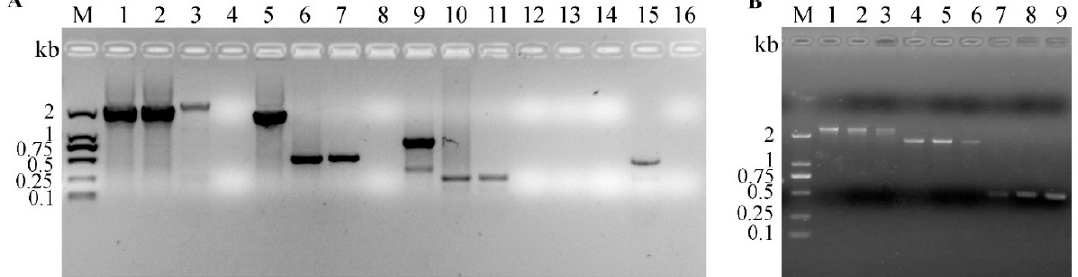
Figure 1. Identification of BoHV-1 gG-/tk-/gE- triple mutant by PCR. ( A ) A fragment of 2183 bp of the intact gE gene fragment in wt BoHV-1 (Lane 1) and BoHV-1 gG-/tk- (Lane 2), and a fragment of 2395 bp including the whole egfp gene and parts of the flanking upstream and downstream sequences (Lane 3) are shown. In addition, the gG gene fragment in wt BoHV-1 (Lane 5), BoHV-1 gG-/tk- (Lane 6), and BoHV-1 gG-/tk-/gE- (Lane 7), and the tk gene fragment in wt BoHV-1 (Lane 9), BoHV-1 gG-/tk- (Lane 10), and BoHV-1 gG-/tk-/gE- (Lane 11) are shown. A fragment of 481 bp including parts of upstream homologous arm gene and egfp gene was detected in BoHV-1 gG-/tk-/gE- (Lane 15), but not in wt BoHV-1 (Lane 13), BoHV-1 gG-/tk- (Lane 14). Lanes 4, 8, 12, 16 represent negative control. ( B ) A fragment of 1685 bp including the whole upstream homologous arm gene, parts of the flanking upstream sequences of the upstream homologous arm gene, and egfp gene were amplified from BoHV-1 gG-/tk-/gE- mutant (Lane 4–6). M represents DNA ladder DL2000.